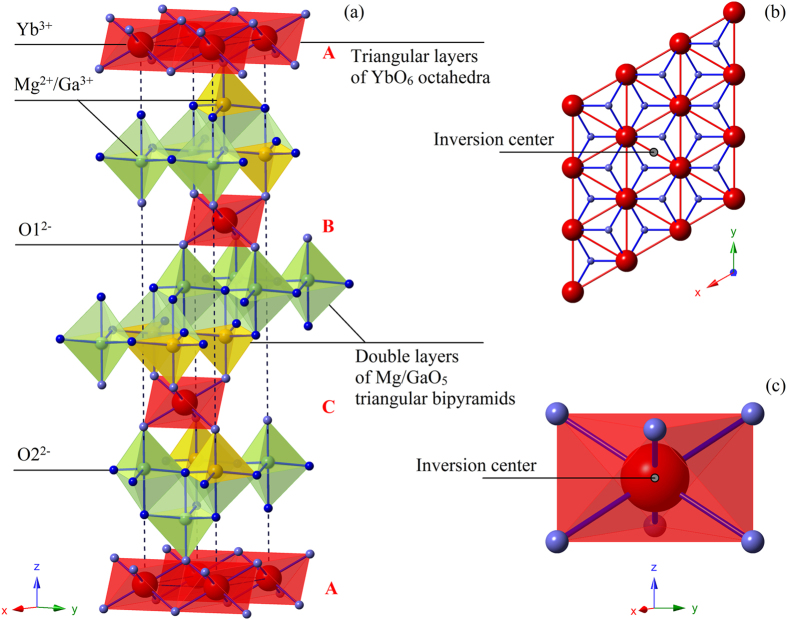
(a) Polyhedral structure of YbMgGaO4. The black dashed lines indicate the unit cell. (b) Top view of the triangular layer of YbO6 octahedra. (c) Local crystal structure around the Yb3+ Kramers ions.